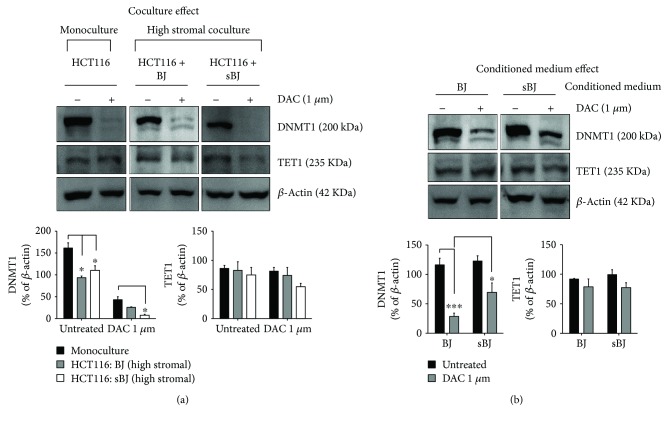
Changes in the expression of DNMT1 and TET1. Representative western blots and densitometry analysis of DNMT1 and TET1 levels in untreated or DAC-treated (a) HCT116 monocultures and cocultures with normal BJ or sBJ and (b) HCT116 monocultures grown in conditioned medium from normal BJ or sBJ cells. DNMT1 and TET1 blots in (a) and (b) are taken from different gels. Data are mean ± SEM, n = 3, ∗∗∗
p < 0.001, ∗
p < 0.05.